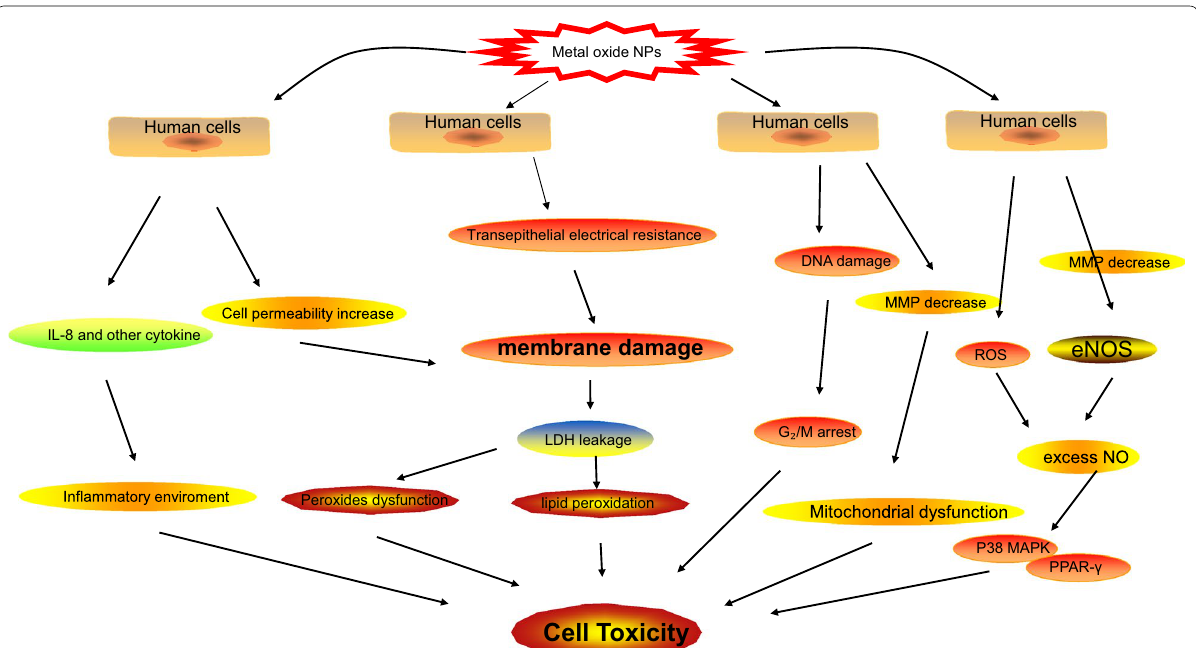
Fig. 2 Mechanism of Metal oxide NPs induced cell toxicity. Include inflammatory environment, membrane damage, excess NO and Mitochondria